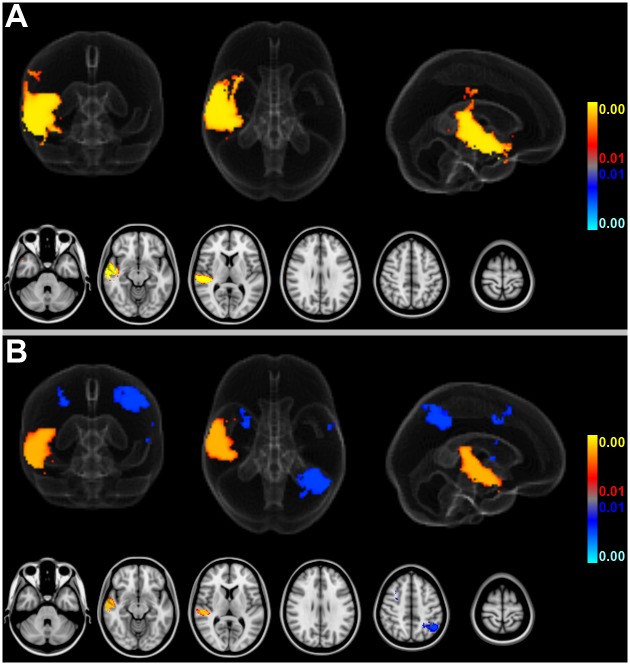
Differences of infarct locations: New AF versus known AF.(A): New AF was associated with more strokes in the central territory of the right MCA than known AF. The reverse comparison of known AF versus new AF did not yield a significant difference. (Red-to-yellow: areas significantly more often associated with strokes in new AF vs. known AF patients; blue-to-lightblue: vice versa; FDR-corrected q = 0.01; age and gender were included as confounds, with infarct volume unaccounted for in this analysis). (B): New AF was also more often associated with right central MCA-strokes compared to known AF after including infarct volume as a confound. Here, the left parietal lobe was significantly less often affected in new AF compared to known AF. (Red-to-yellow: areas where new AF was associated with significantly more strokes than in patients with known AF; blue-to-lightblue: vice versa; FDR-corrected q = 0.01; with removal of the confounding effect of cubic root infarct volume, age and gender).